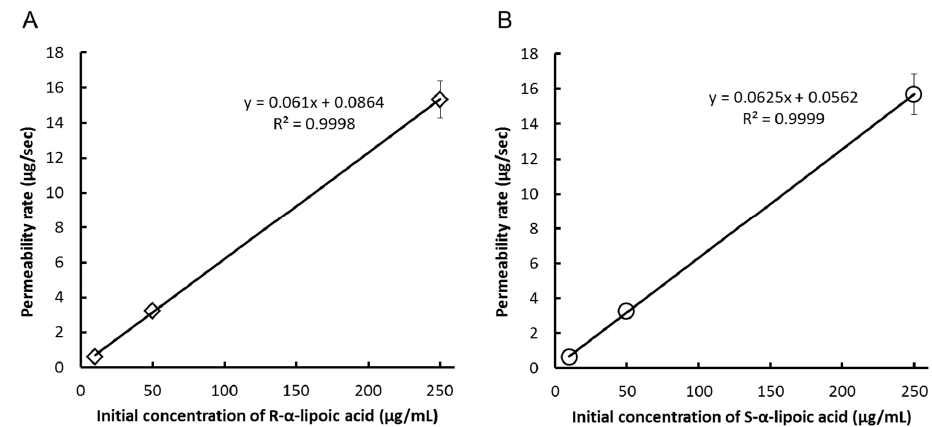
Figure 3. Correlation between initial concentration versus permeability rate of ( A ) R- α -lipoic acid or ( B ) S- α -lipoic acid addition after addition of α -lipoic acid to Mardin-Darby canine kidney II cell. Meanwhile, LA was transported across the monolayer of MDCKII much faster than that of Caco-2.